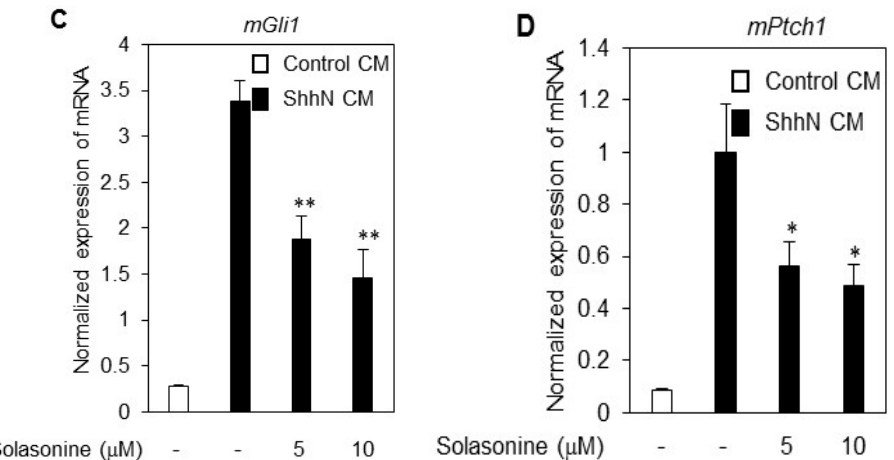
Figure 1. Solasonine inhibits Hh pathway activity in light II cells. ( A ) Chemical structure of solasonine. ( B ) Solasonine inhibited the Gli-luciferase activity in response to ShhN CM. Light II cells seeded in